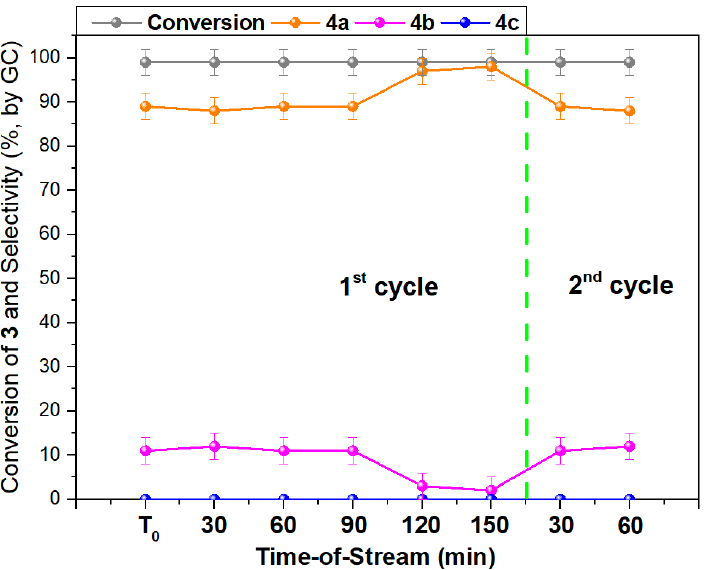
Figure 9. Catalyst stability. Reaction conditions: 3 (0.1 M in methanol), Pd-N/Ca (50 mg), 50 °C,